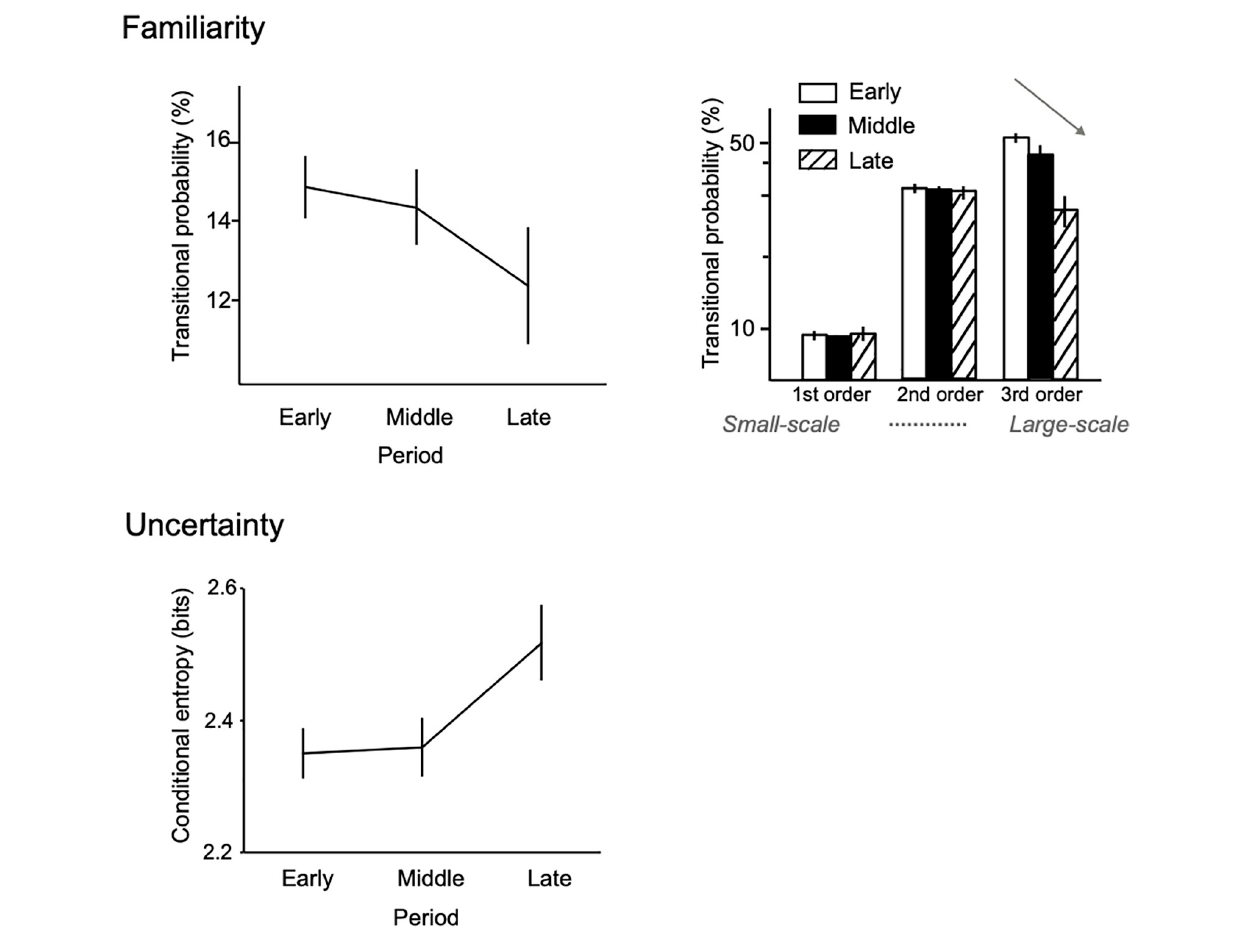
FIGURE 2 | Statistical creativity in the uncertainty fluctuation of musical composition. Figure adapted from a previous article (Daikoku, 2019b). From the early to the late periods of Beethoven’s lifetime, the predictable patterns that ubiquitously appear in all of his piano sonatas (familiar sequence) were decreased, whereas the uncertainties were gradually increased. Further, these findings were more prominent in higher- (deeper), rather than lower-order statistical learning models (right). This may suggest that higher-order statistical learning reflects novelty-seeking (creative) behavior over a composer’s